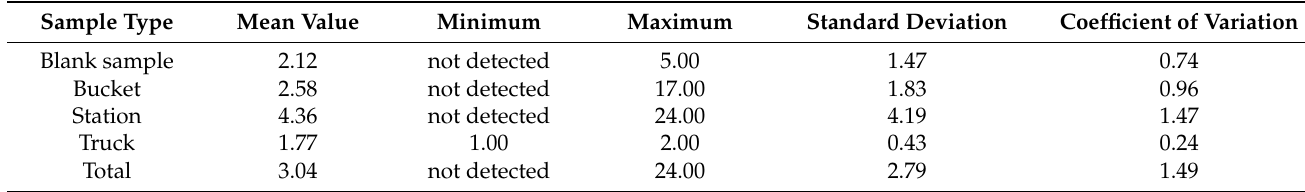
Table 6. Mercury content levels of ambient air (unit: ng/m 3